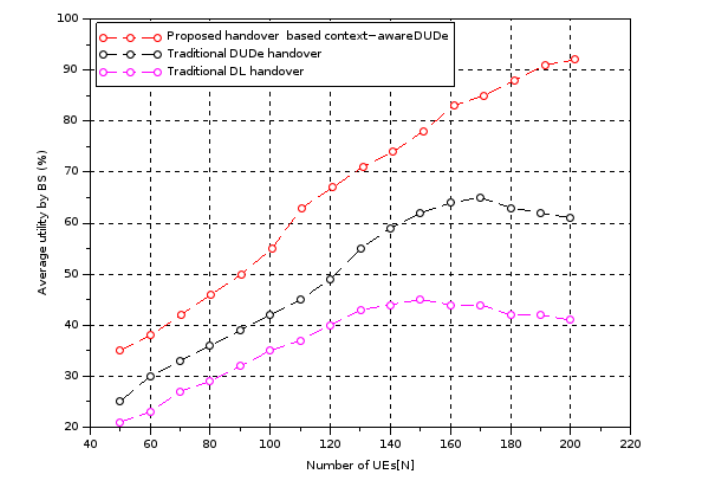
Figure 2. The utilities rate for the BS regarding the number of UEs N, under the considered approaches: 5 macro BSs with q ul = 10 q dl = 10 and 15 femto BSs with q ul = 5 q dl = 5. DL: